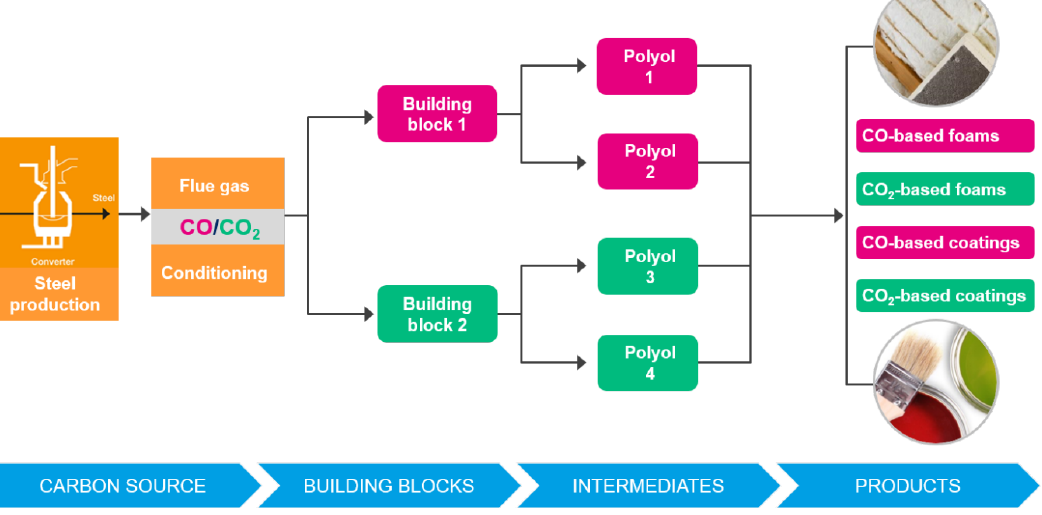
Figure 31. The Carbon4Pur project concept (source: ThyssenKrupp Steel).